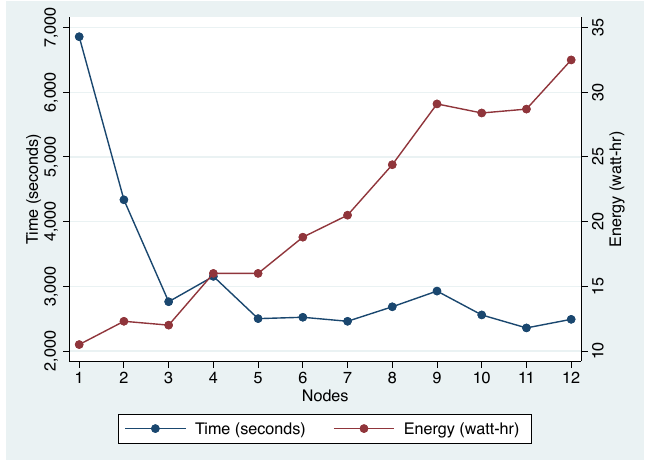
Figure 10. Execution time vs. energy consumption of a Montage 0.5 degree workflow on varying sizes of cluster.